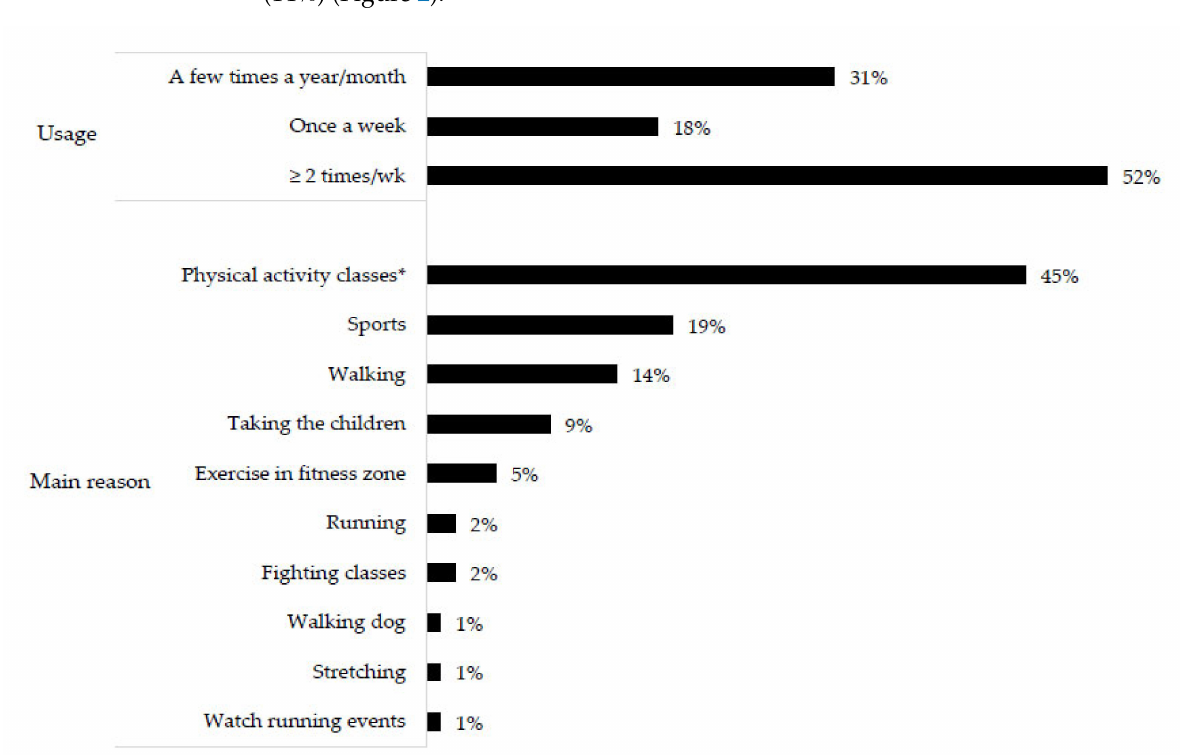
Figure 2. Descriptions of the usage of public open spaces by adults in primary health care. S ã o Jos é dos Pinhais, Southern Brazil, 2019 ( n = 97) (* aerobics, Zumba, and functional